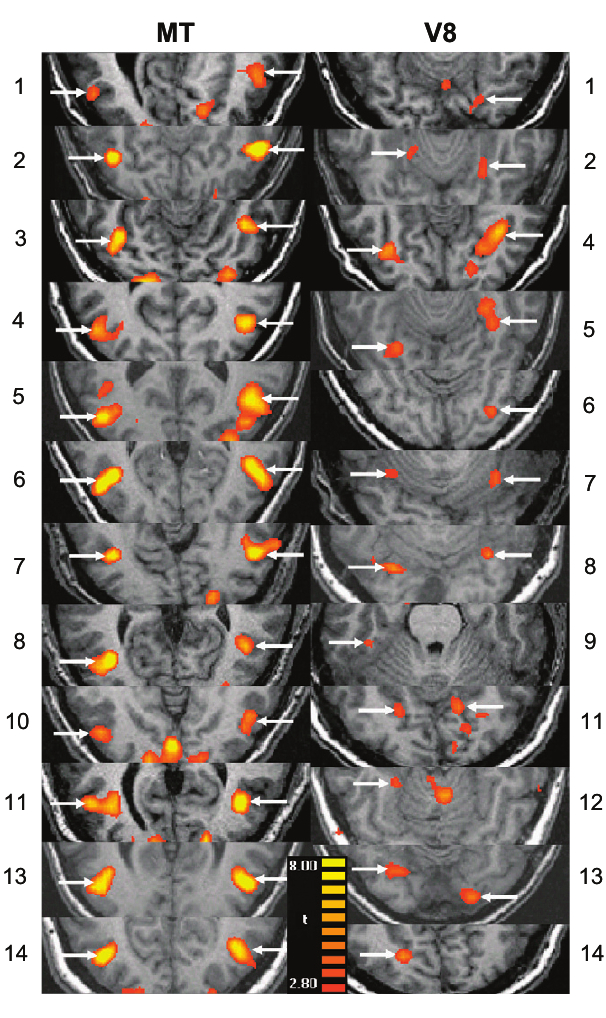
Figure 2. Individually defi ned MT and V8 ROIs. Arrows indicate the activation(s) from which the ROI(s) for each subject (N = 14) were generated. The left column is for motion area MT and the right is for color area V8. The numbers 1–14 refer to the subjects and correspond to those in Table 2